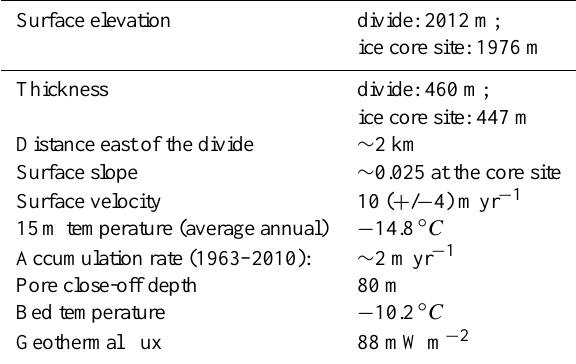
Table 1. LARISSA Site Beta, Bruce Plateau site